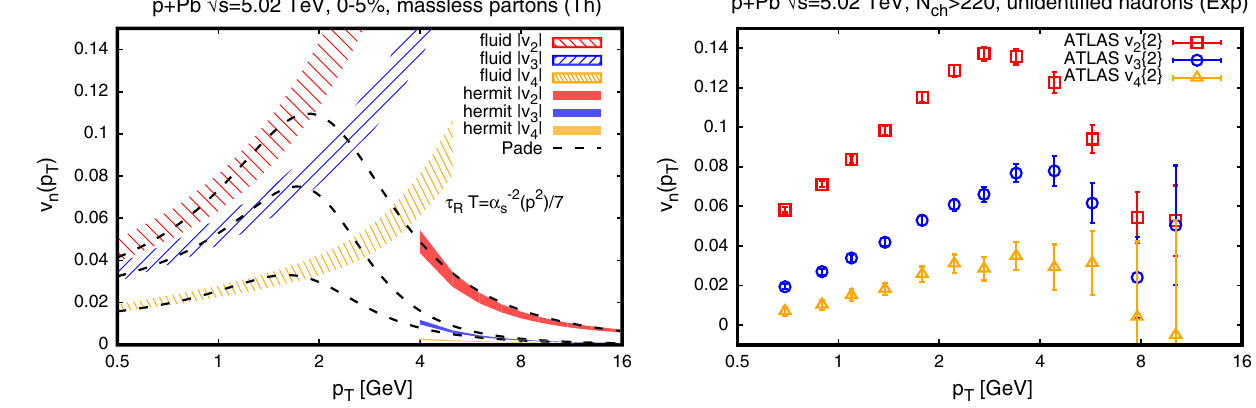
Fig. 5 Left: Results for momentum anisotropy coefficients (cid:9) v (τ , p ) (cid:10) for massless partons from theoretical calculations at n f T low momenta (zeroth order hydrodynamic gradient expansion) and high momenta (first order eremitic expansion). For illustration, low and